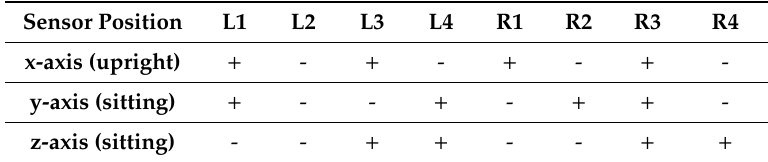
Table 1. Expected signs of median accelerations provided by tri-axial wrist-worn accelerometers during sitting and upright body